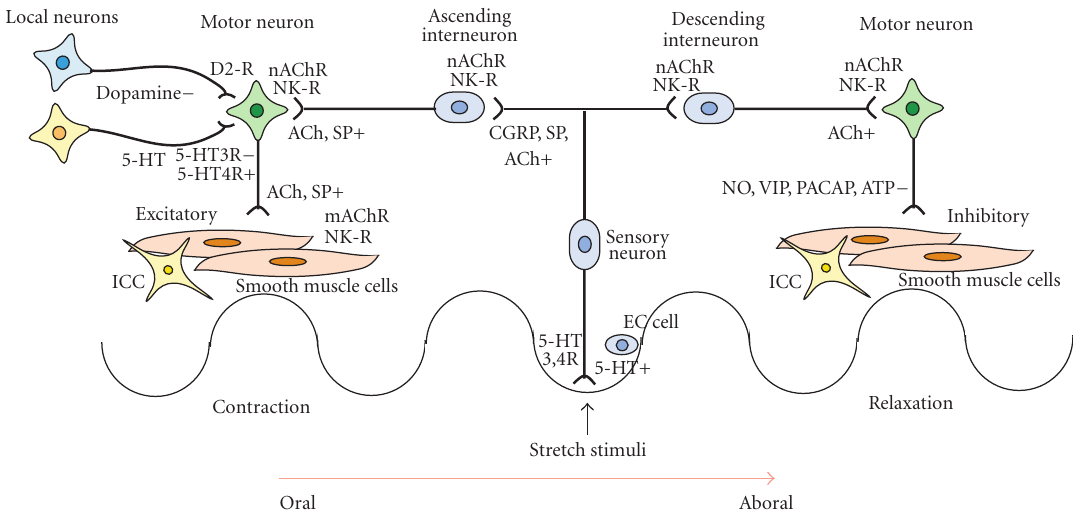
Figure 4: Enteric neural circuitry relevant to peristaltic reflex. Following mucosal stimulation, 5-HT is released from enterochroma ffi n cells to intrinsic primary sensory neurons (with 5-HT3 and 5-HT4 receptors) and extrinsic vagal and spinal sensory neurons (with 5-HT3 receptors). Sensory neurons release calcitonin gene-regulated peptide (CGRP), substance (SP), and acetylcholine (ACh) to interneurons. Interneurons release ACh and SP orally to excitatory motorneurons while ACh is released aborally to inhibitory motorneurons. Excitatory motorneurons release ACh and SP to smooth muscle cells while inhibitory motorneurons release nitric oxide (NO), vasoactive intestinal peptide (VIP), pituitary adenylate cyclase-activating polypeptide (PACAP), and adenosine triphosphate (ATP) to smooth muscle cells. 5- HT also acts as an excitatory modulator on motor neurons (with 5-HT3 and 5-HT4 receptors) whereas dopamine seems to be an inhibitory modulator on motor neurons (with D2 receptor). Interstitial cells of Cajal (ICC) interact with smooth muscle cells for generating rhythmicity (with Ach, VIP, and NO